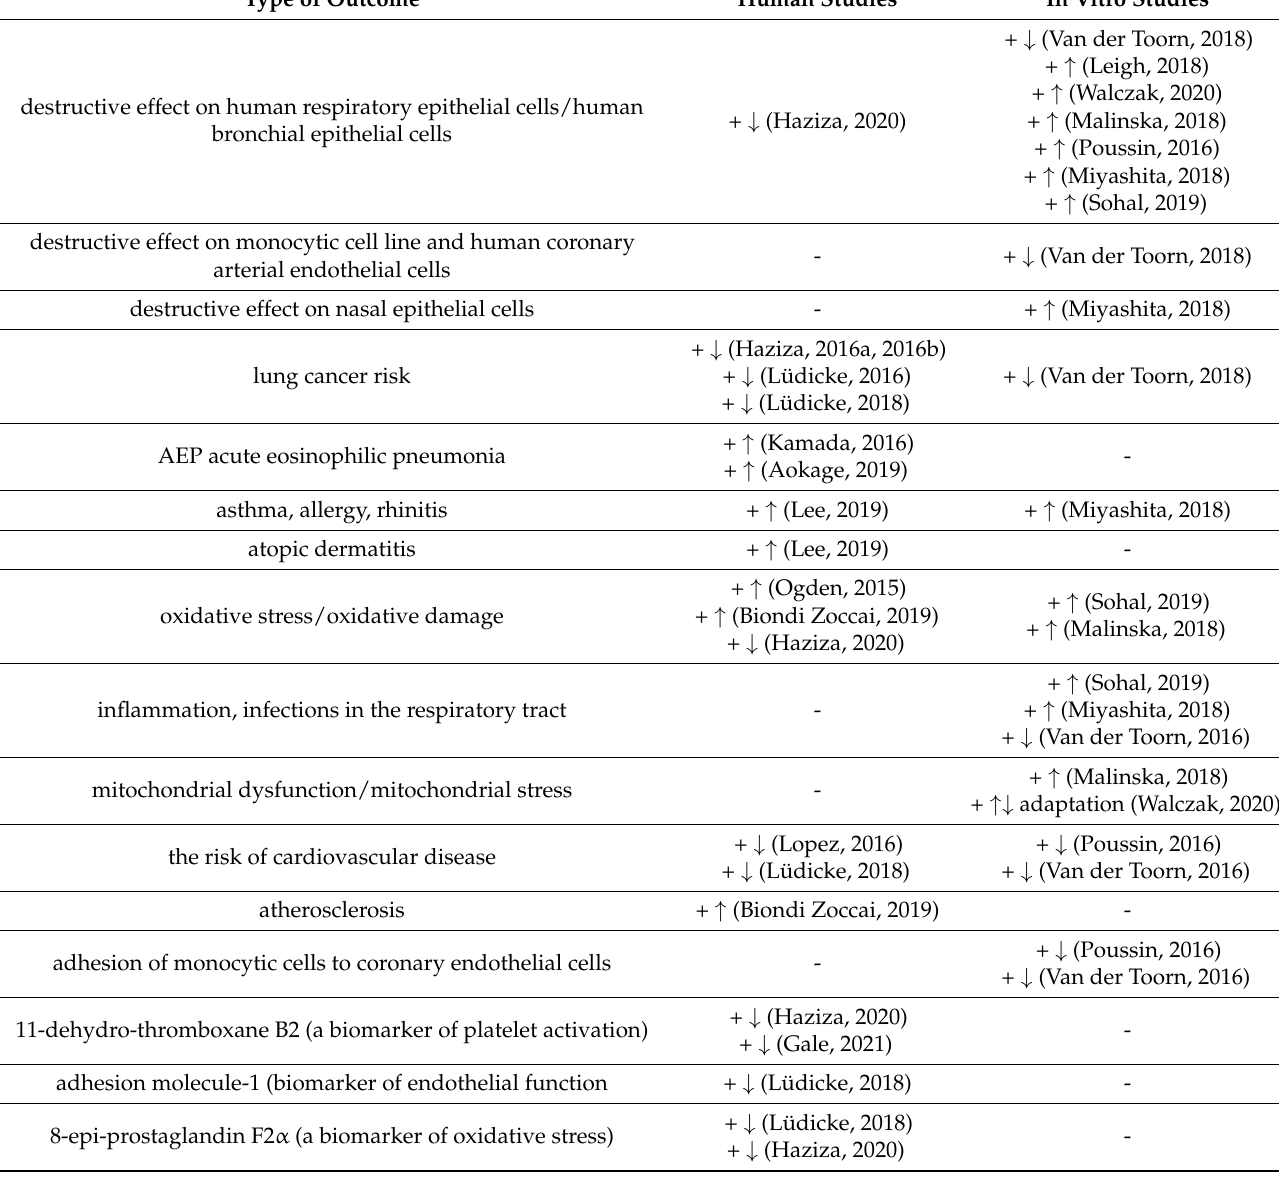
Table 2. The adverse health effects of expsoure to IQOS/HTP. Type of